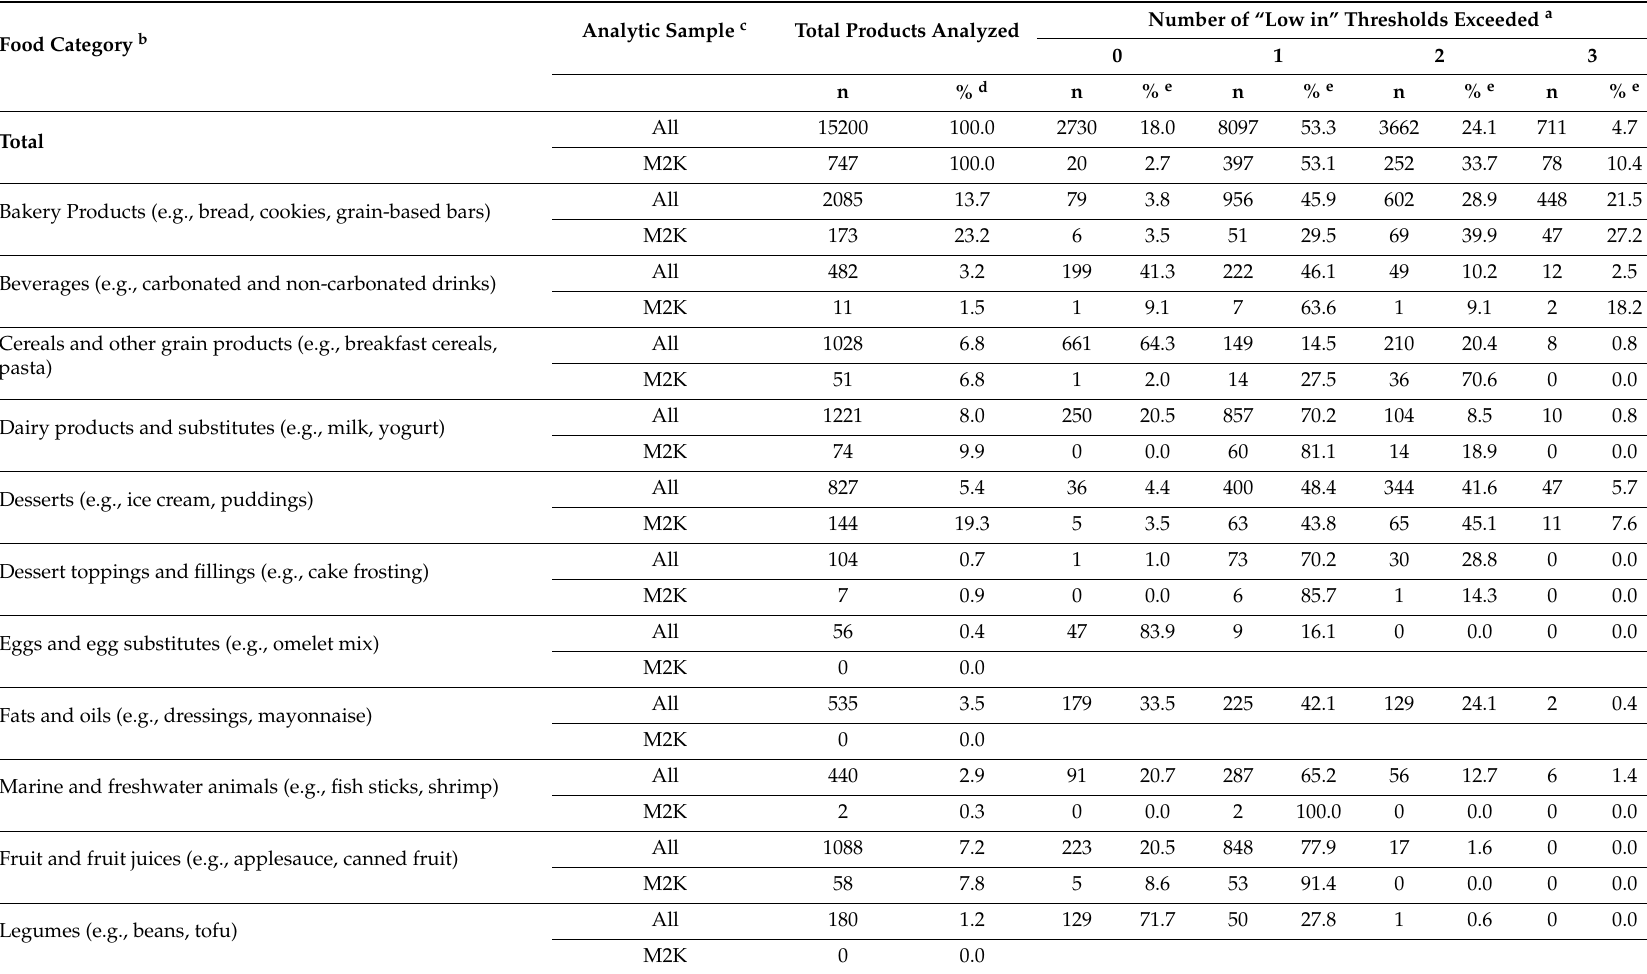
Table 3. Number (n) and proportion (%) of products exceeding zero, one, two or three “low in”